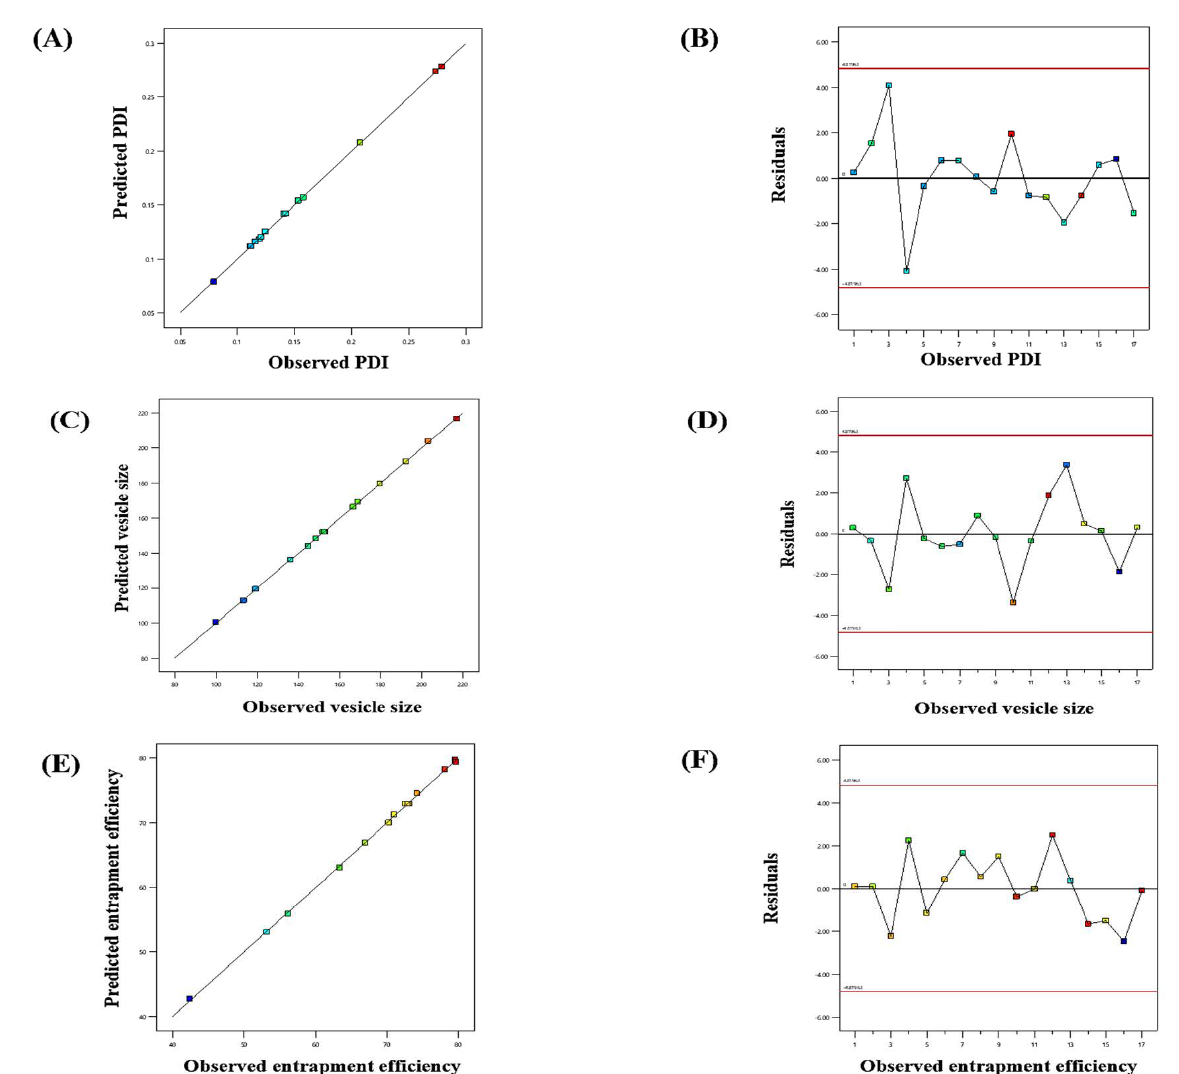
Figure 2. Linear correlation plots ( A , C , E ) between actual and predicted values and the corresponding residual plots ( B , D , F ) for various responses.